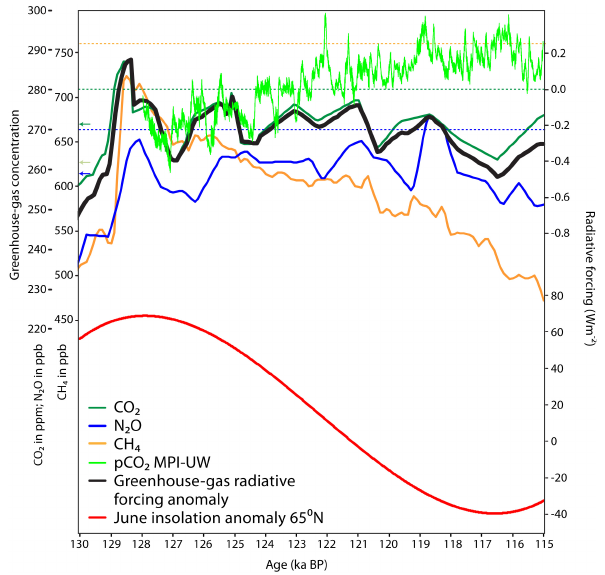
Fig. 1. In the upper part the changes in the main GHG concentra- tions over the period 130–115kaBP are depicted. Concentrations are according to the PMIP3 protocol (http://pmip3.lsce.ipsl.fr/), which is based on the ice-core data of Luthi et al. (2008), Louler- gue et al. (2008) and Schilt et al. (2010) for CO 2 , CH 4 and N 2 O respectively. The corresponding pre-industrial values are given by the dotted lines. In constructing the forcing scenarios, a linear in- terpolation was applied to the data to get a 1yr resolution. The bold black line presents the combined radiative forcing of the three main GHG concentration changes (W m − 2 ; concentrations accord- ing to the PMIP3 protocol; formulation of radiative forcing after Houghton et al., 2001). The fixed average LIG GHG concentrations applied in the CCSM3 simulation are depicted by the arrows on the left-hand side of the upper panel. In the MPI-UW simulation, the ra- diative forcing of the GHGs is prognostically calculated from sim- ulated changes in the carbon cycle. The resulting CO 2 changes are depicted in light green. In the lower part of the figure, the June inso- lation anomaly for 65 ◦ N is given (W m − 2 relative to pre-industrial values; Berger,